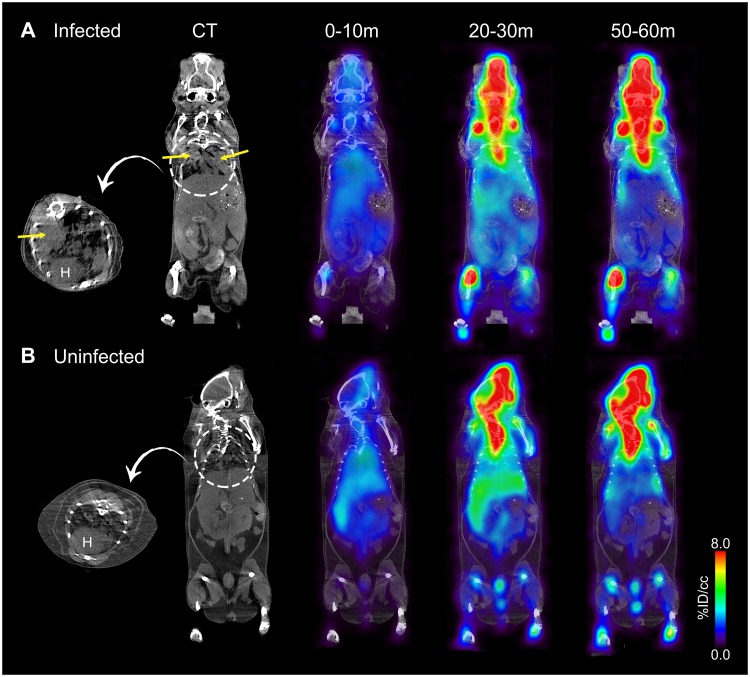
Dynamic PET/CT imaging of 5-[18F]F-PZA in infected and uninfected mice.(A) Dynamic PET/CT images of a representative M. tuberculosis-infected mouse. Lung consolidations (yellow arrows) can be observed in the transverse and coronal CT sections. PET/CT images 0 to 10 min, 20 to 30 min and 50 to 60 min post tracer administration. (B) Dynamic PET/CT images of a representative uninfected control mouse. The images showed in the figure are representatives of 3 animals. H = heart.